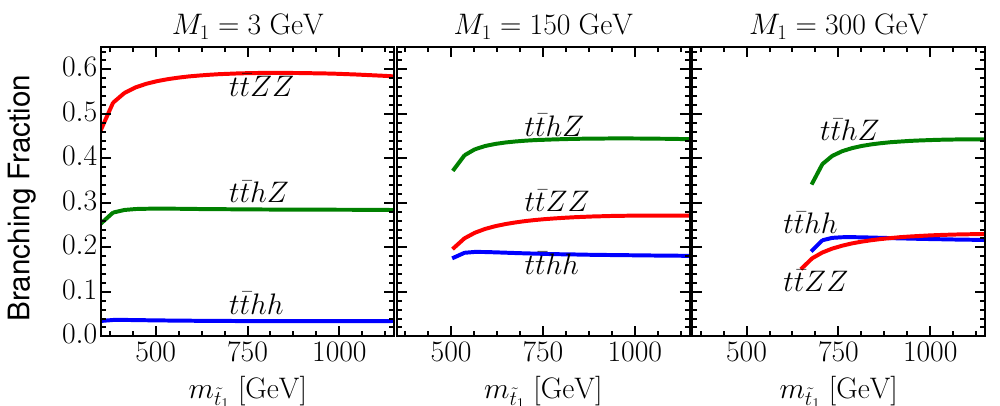
E E E , t (cid:22) thZ and t (cid:22) tZZ as a T T T 6 6 6